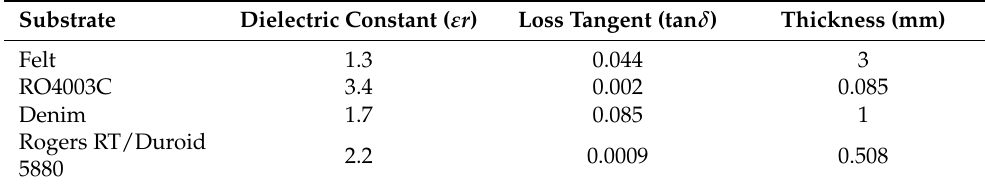
Table 1. Characteristic of Substrate Materials.